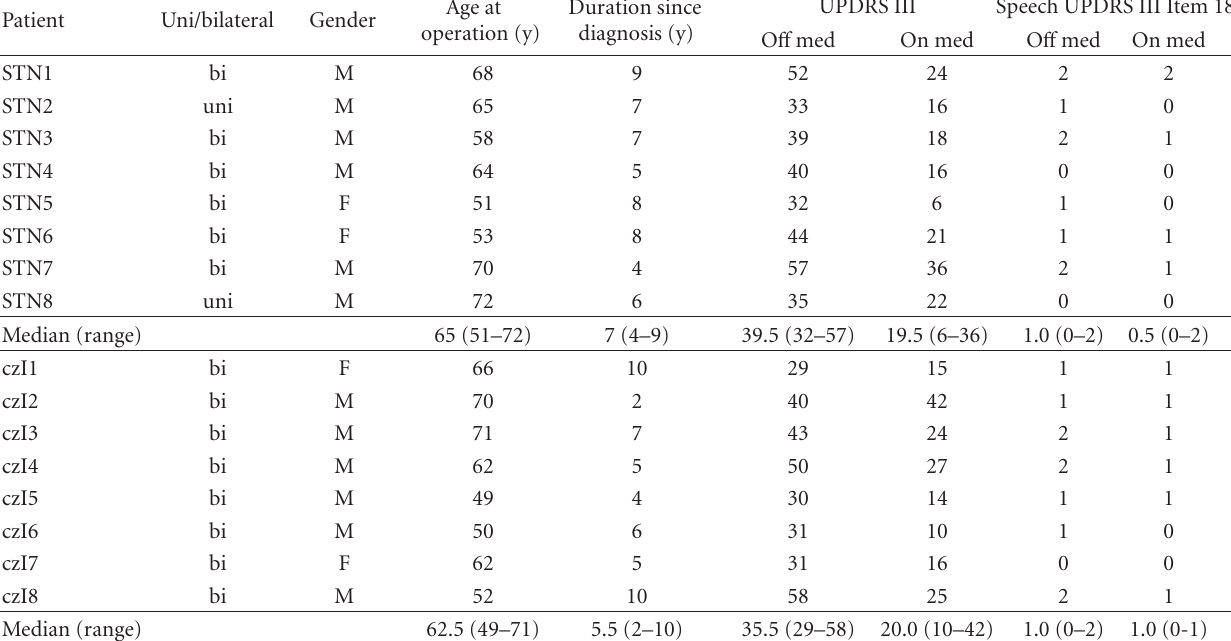
Table 1: Characteristics of patients in the two surgical groups. There were no statistical di ff erences between the groups for age, duration since diagnosis, or any of the UPDRS